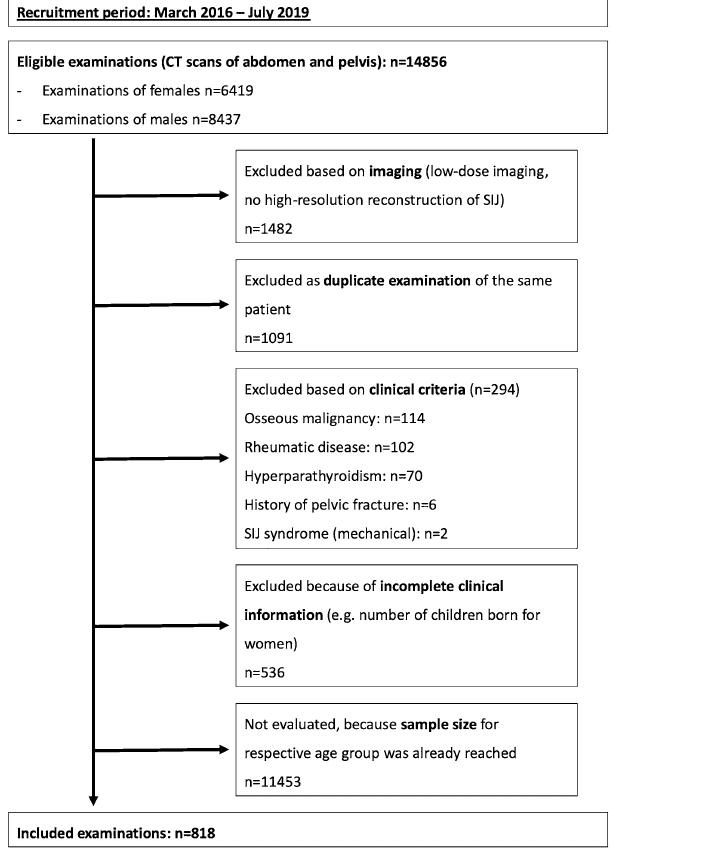
Figure 1. Flow diagram of patient